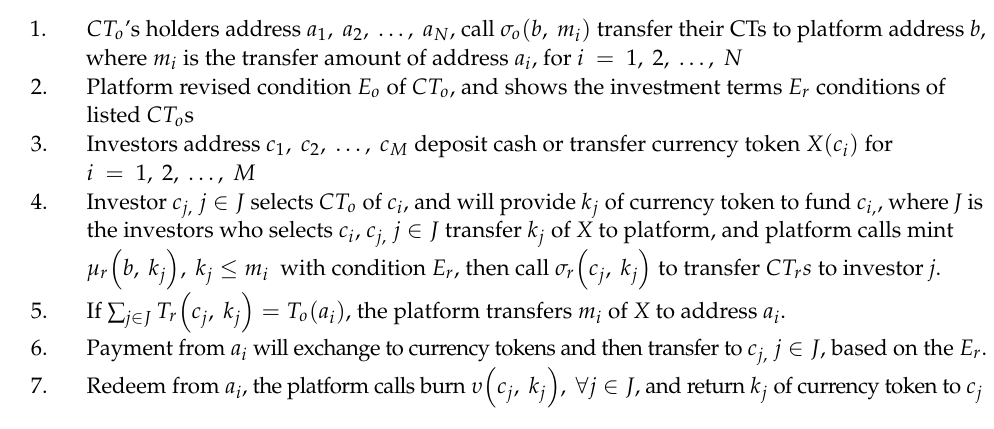
Algorithm 4 The processes and the operations of P2P